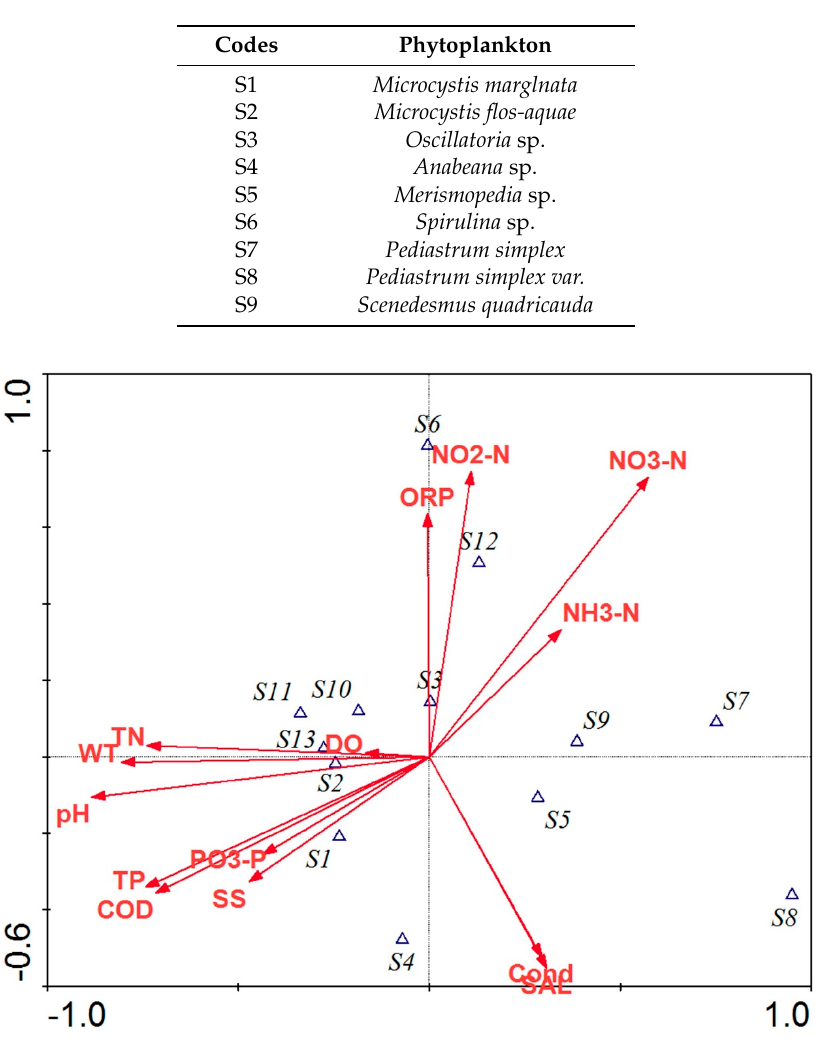
Figure 7. Species-environment biplot from CCA. The points represent the individual phytoplankton species and the arrows represent each environmental variable pointing in the direction of its maximum change across the diagram during the study. The species are denoted with codes referring to Table 2.